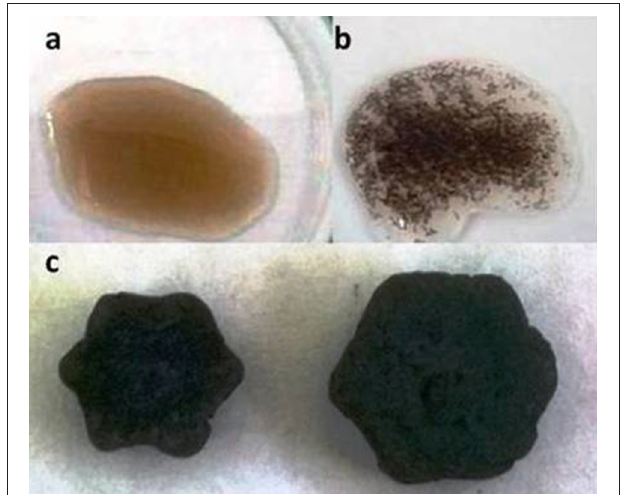
FIGURE 2 | The reaction mixture before (a) and after (b) the addition of TETA. (c) Well shaped hexagonal aerogels from the hydrothermal treatment of TETA with